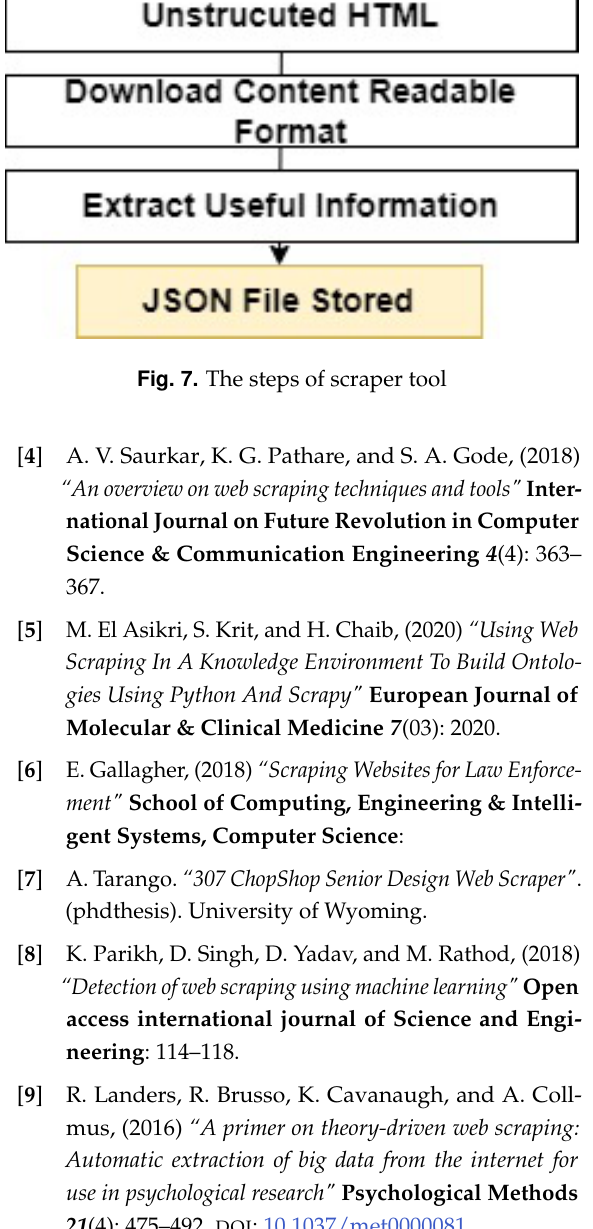
Fig. 8. Domain wise web